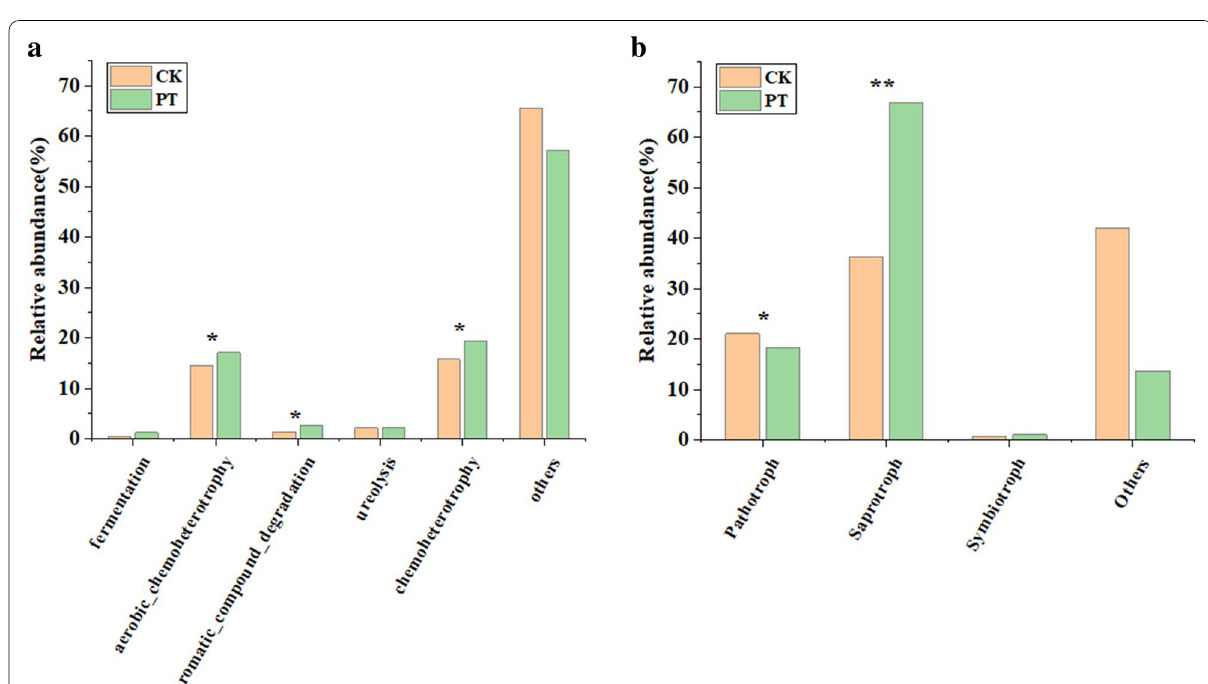
Fig. 9 Comparison of dominant functional groups of microbial communities of tobacco rhizosphere between CK and PT treatments. a Functional prediction of bacterial communities using FAPROTAX. b Functional annotation of fungal communities using FUNGuild ( p < 0.05*, p <